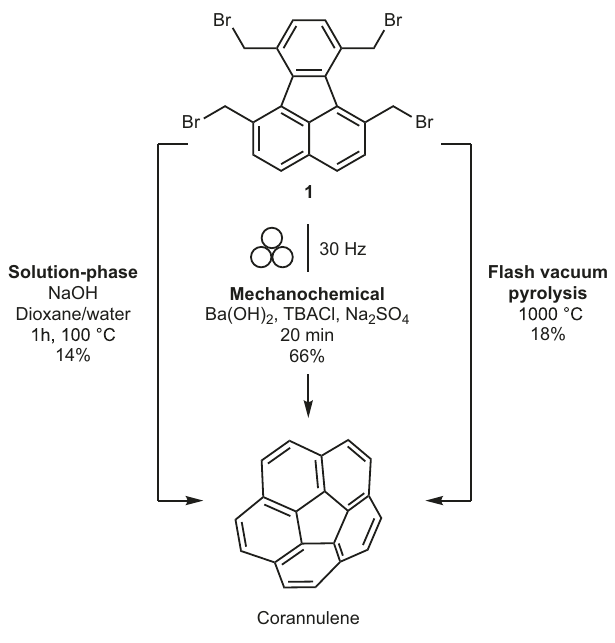
Fig. 1 Comparison of different synthetic pathways to corannulene. A comparison of the gas-phase, solid-phase and liquid-phase synthesis of corannulene.